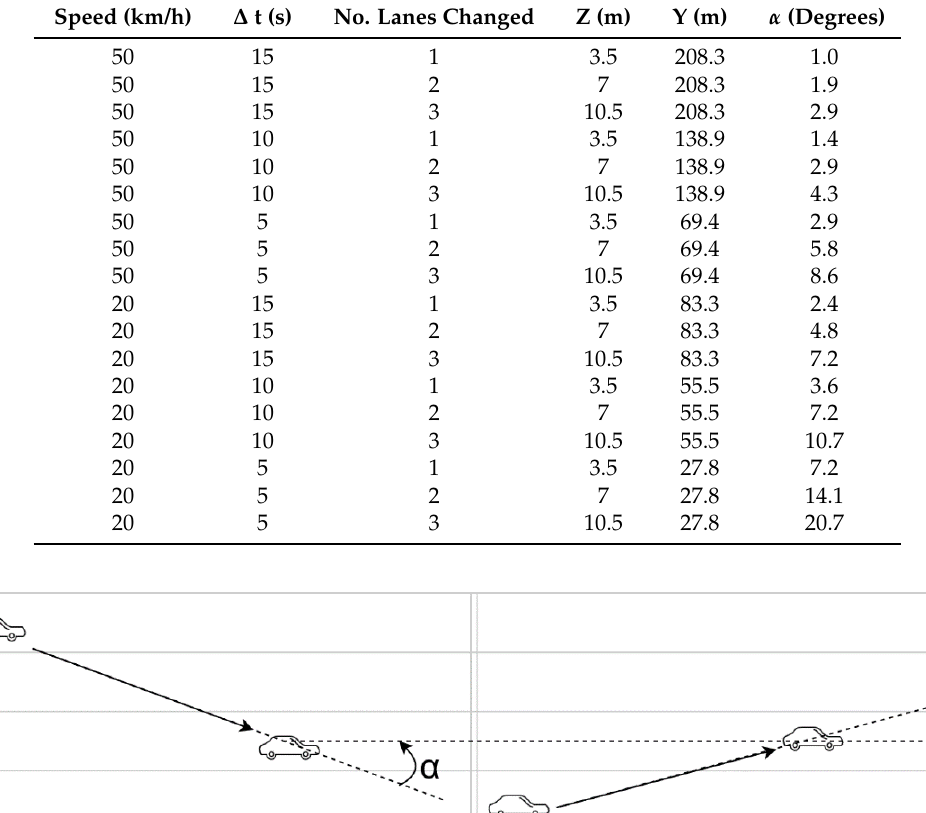
Table 1. Possible cases for the situation depicted in Figure 4.